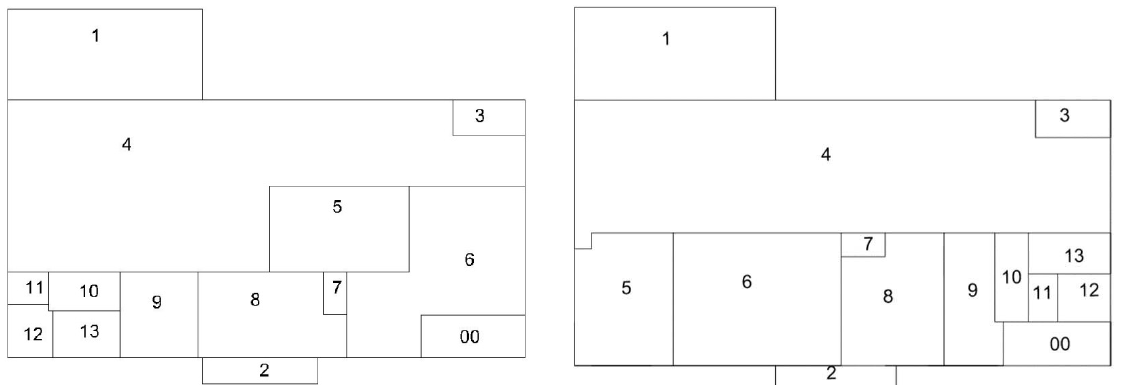
Fig. 5. Layout based on SLP method